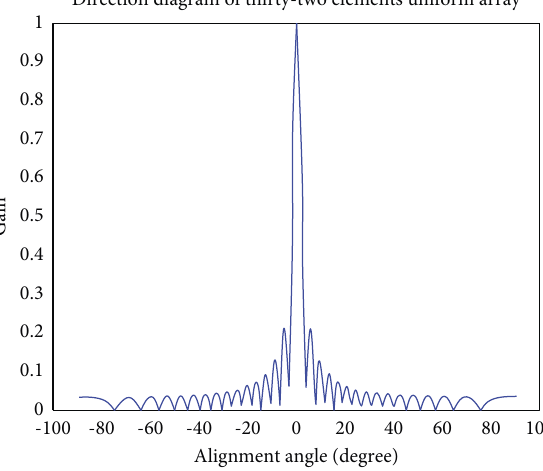
Figure 5: Directional diagram of 32-element uniform linear array.